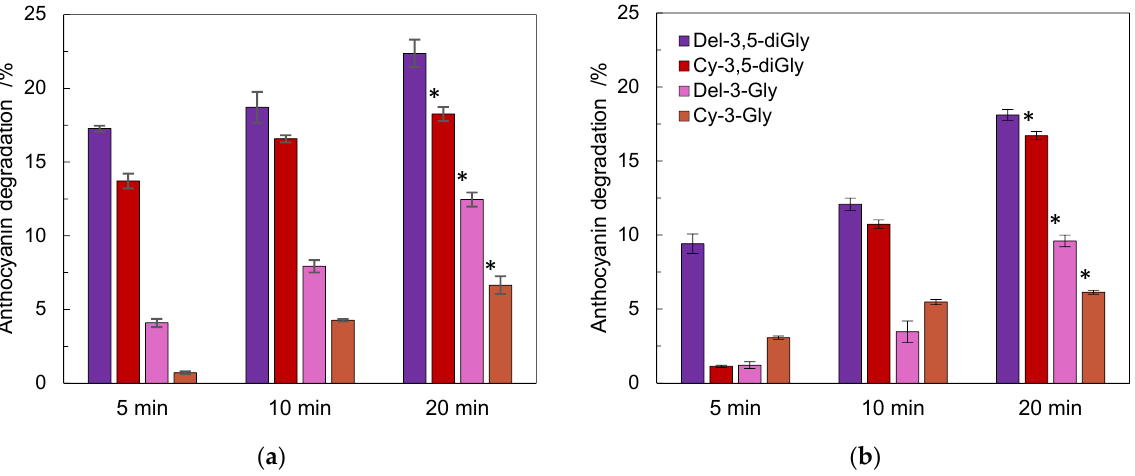
Figure 1. Effect of the duration of thermal treatment at 80 °C on the anthocyanin (delphinidin-3,5- O -di-glucoside, cyanidin-3,5- O -di-glucoside, delphinidin-3- O -glucoside, and cyanidin-3- O -glucoside) degradation in pomegranate juice ( a ) and in the mixture of anthocyanin standards ( b ). Data are means ± SD. *, indicates dissimilarity versus 5–20 min standardized degradation rate of delphinidin-3,5- O -di-glucoside (f2 < 50).